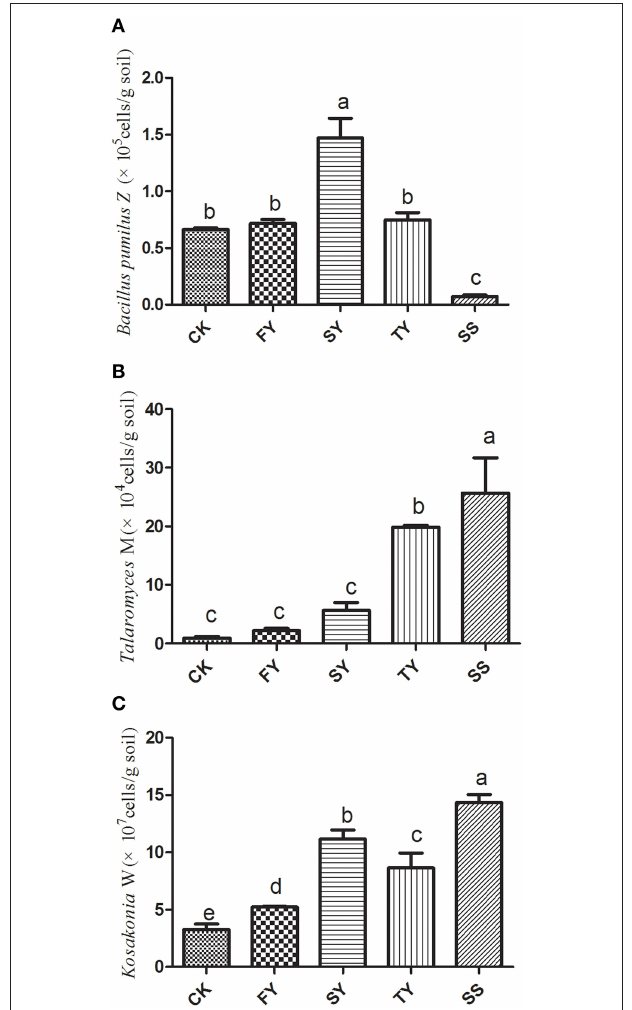
FIGURE 1 | The content of Bacillus pumilus Z (A), Talaromyces M (B), and Kosakonia W (C) in R. pseudostellariae rhizosphere soil after a different number of years of monoculture. FY, SY, TY represent the first, second, and third cropping of R. pseudostellariae , respectively, grown in pots with the soil from the same plot; SS represents the soil around the pathogenic site of R. pseudostellariae. Columns with different letters are statistically different (LSD-test, p < 0.05